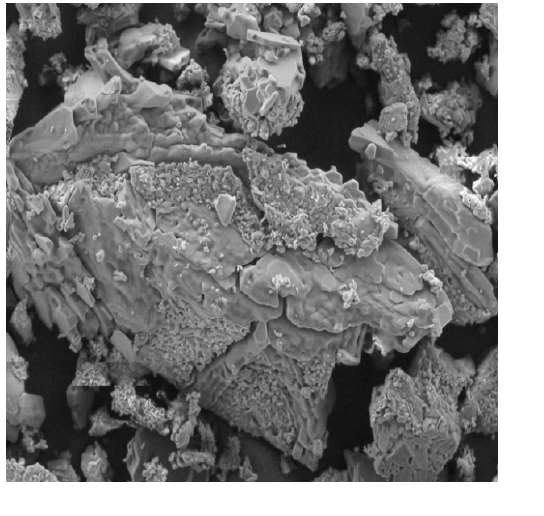
Figure 3. Powder X-ray Diffractometry XRD of ( A ) pure drug, ( B ) formula with glucose as a carrier (FN1), ( C ) formula with maltodextrin as a carrier (FN2), and ( D ) formula with mannitol as a carrier